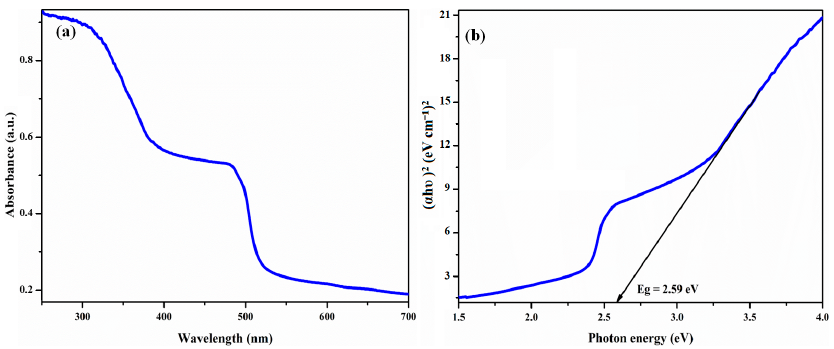
Figure 5. ( a ) DRS spectrum and ( b ) Tauc plot of Co-doped ZnO/CdS nanosheets.